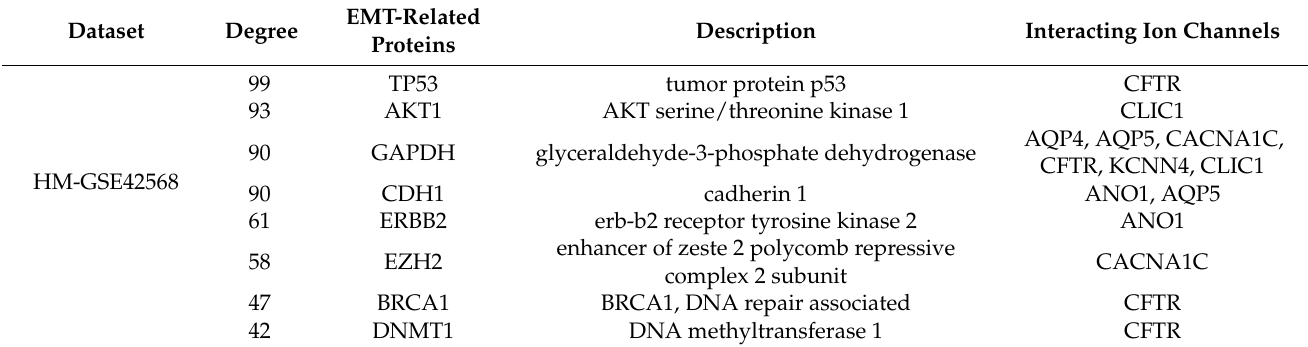
Table 6. A list of ion channels interacting with top 15 EMT-related proteins with the highest degree centrality measure in protein–protein interaction networks of modules on HM DEGs in breast cancer GSE42568 dataset.